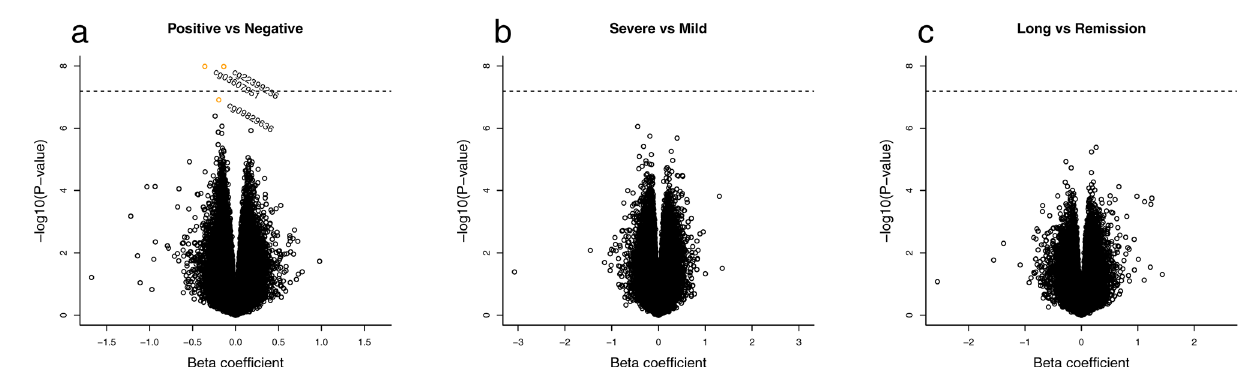
Figure 4. Volcano plots for the pooled sample of males and females in the analysis of autosomal probes. The plots display the estimated beta coefficients against −log 10 of the P-values. ( a ) COVID-19 positive (n = 109) versus COVID-19 negative (n = 73), ( b ) severe COVID-19 (n = 61) versus mild COVID-19 (n = 48), and ( c ) long-COVID (n = 41) versus remission (n = 63). The dotted horizontal line refers to the Bonferroni threshold (0.05/776,892 CpG sites), and the orange-colored dots are the significant CpGs at FDR <